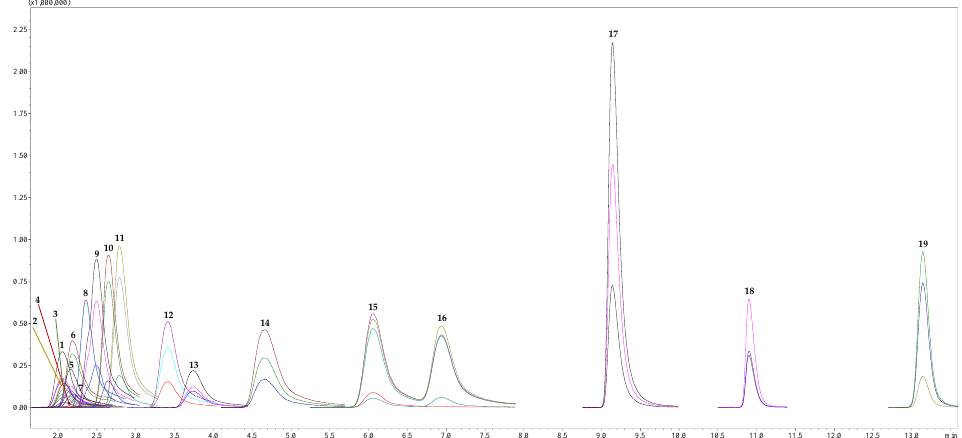
Figure 1. Selected ion chromatogram in MRM mode represents the profiles of 18 amino acids and one metabolite of tryptophan in a standard solution at the concentration of 2.5 µ M L − 1 . Note: 1—Cystine (Cys); 2—Aspartic acid (Asp); 3—Serine (Ser); 4—Glycine (Gly); 5—Threonine (Thr); 6—Glutamic acid (Glu); 7—Alanine (Ala); 8—Proline (Pro); 9—Histidine (His); 10—Lysine (Lys); 11—Arginine (Arg); 12—Valine (Val); 13—Methionine (Met); 14—Tyrosine (Tyr); 15—Isoleucine (Ile); 16—Leucine (Leu); 17—Phenylalanine (Phe); 18—Tryptophan (Trp); and 19—Tryptamine